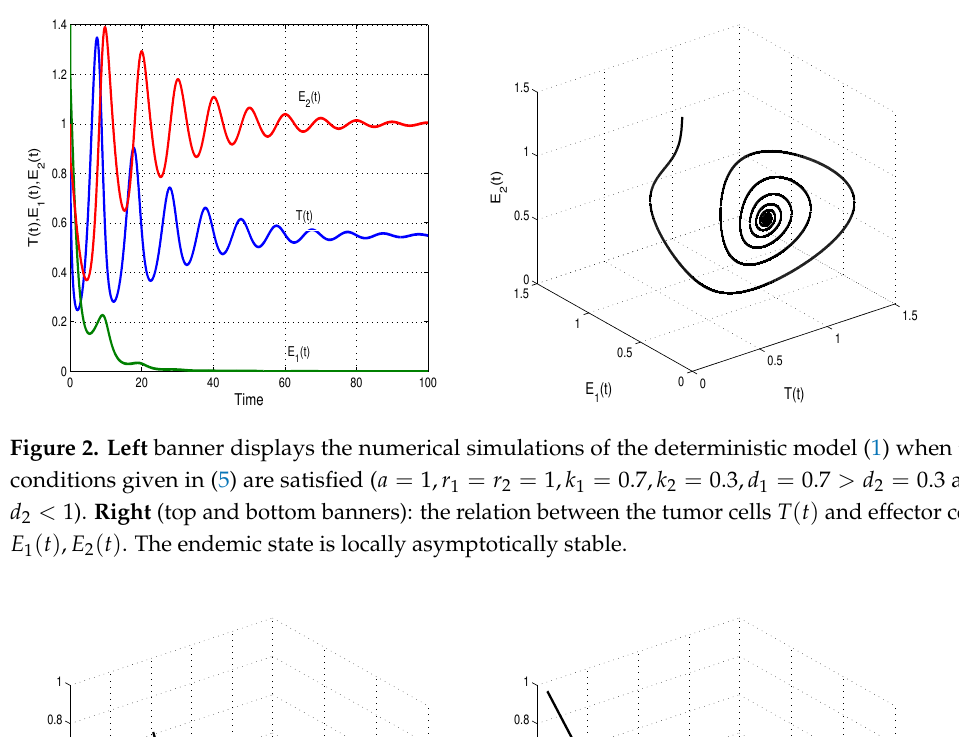
Figure 1. Left banner shows the numerical solutions of the deterministic model (1) when the conditions given in (4) are satisfied ( a = 1, r 1 = r 2 = 1, k 1 = 0.3, k 2 = 0.7, d 1 = 0.3 < d 2 = 0.7 and d 1 < 1). Right (top and bottom banners): the relation between the tumor cells and effector cells E 1 ( t ) , E 2 ( t ) . The system converges to a stable steady state.